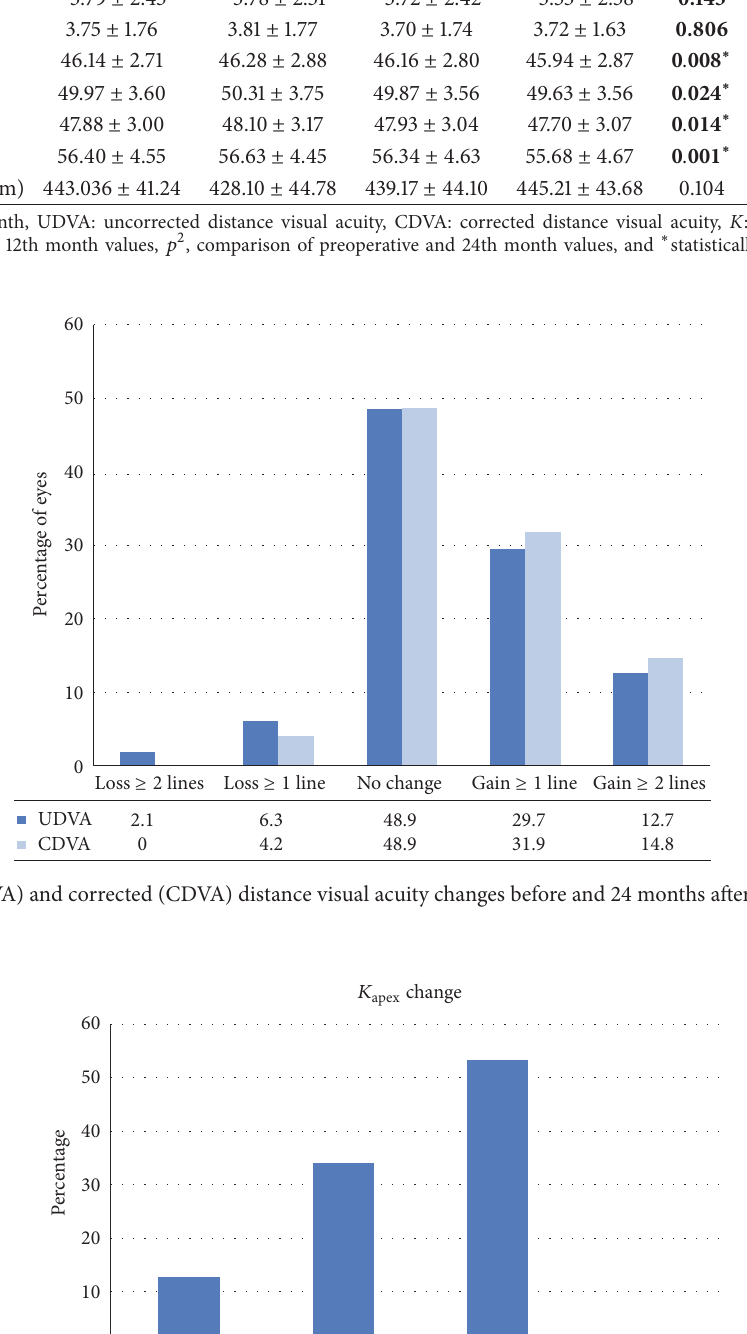
) values before and 1, 6, 12, and 24 months after accelerated corneal cross-